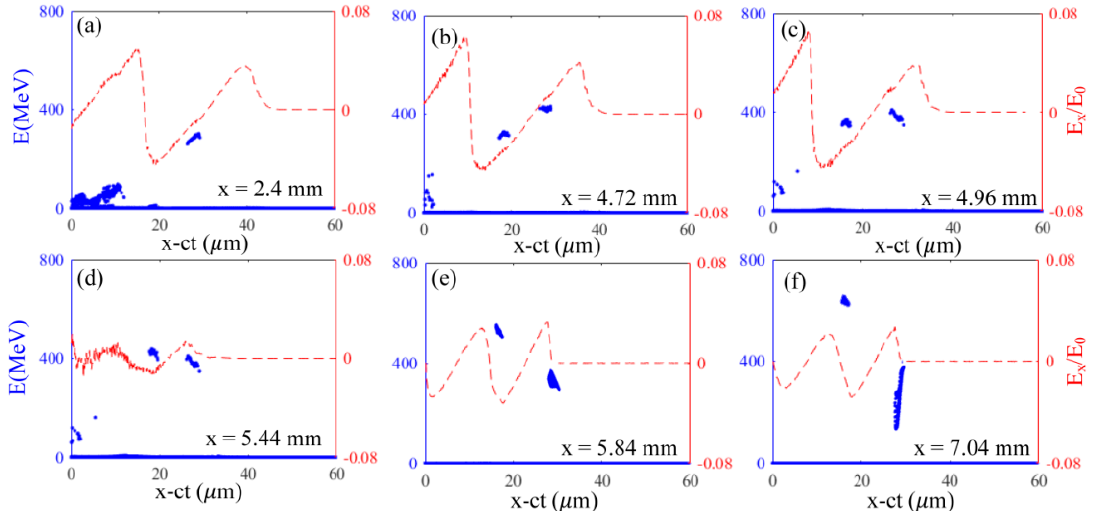
Figure 4. On-axis acceleration field E x /E 0 and the corresponding electron space-phase distribution at ( a ) x = 2.4 mm ( b ) x = 4.72 mm ( c ) x = 4.96 mm ( d ) x = 5.44 mm ( e ) x = 5.84 mm ( f ) x = 7.04 mm.